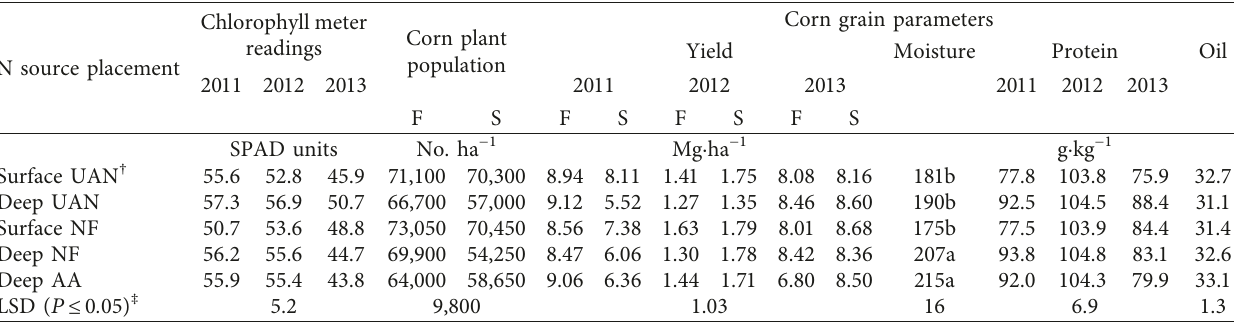
Table 5: Chlorophyll meter readings, plant population, grain yield, moisture, protein, and oil concentration response to nitrogen sources/ placements at 168kg · N · ha − 1 . Data were combined over factors or years in the absence of a significant interaction. Surface treatments were no-tillage with surface applied nitrogen and deep treatments were strip tillage with deep banded nitrogen application. N source